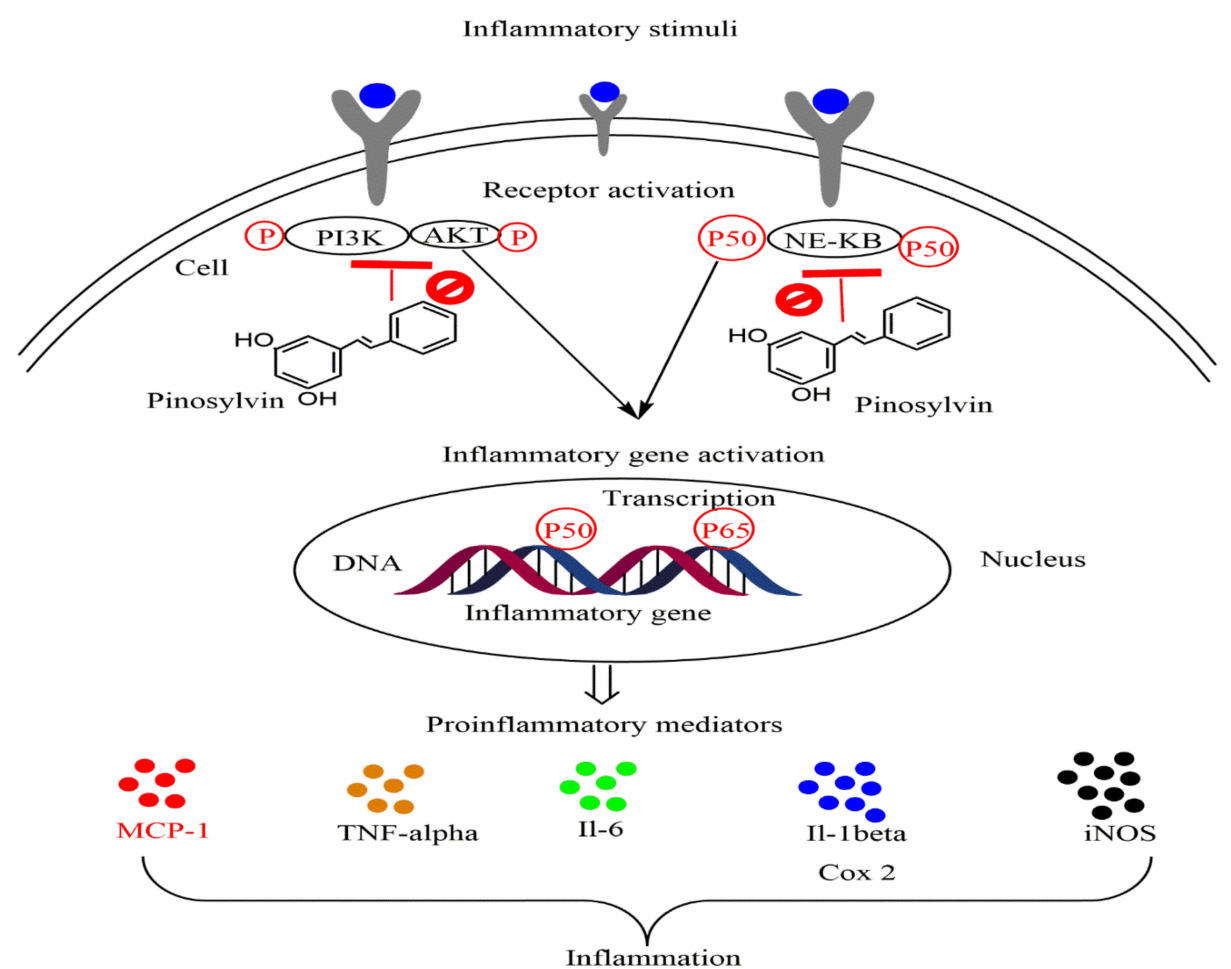
Figure 2. Anti-inflammatory effects of pinosylvin. This figure illustrates the ability of pinosylvin to reduce the expression of some proinflammatory cytokines and enzymes, probably via the inactivation of NF- κ B and the PI3K/Akt pathway. Abbreviations: NF- κ B, nuclear factor kappa B; NO, nitric oxide; COX-2, cyclooxygenase-2; iNOS, inducible nitric oxide synthase; IL6, interleukin 6; MCP1, monocyte chemotactic protein 1; TNF- α , tumor necrosis factor- α